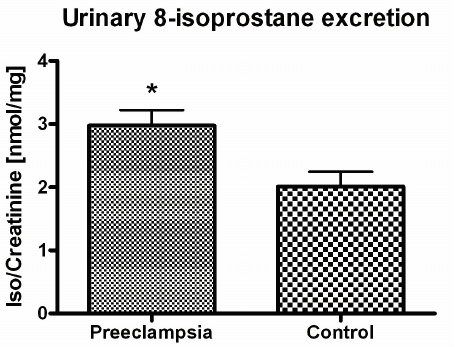
Figure 1. Urinary isoprostane excretion as calculated per mg of creatinine in preeclamptic women vs. control ( * p <